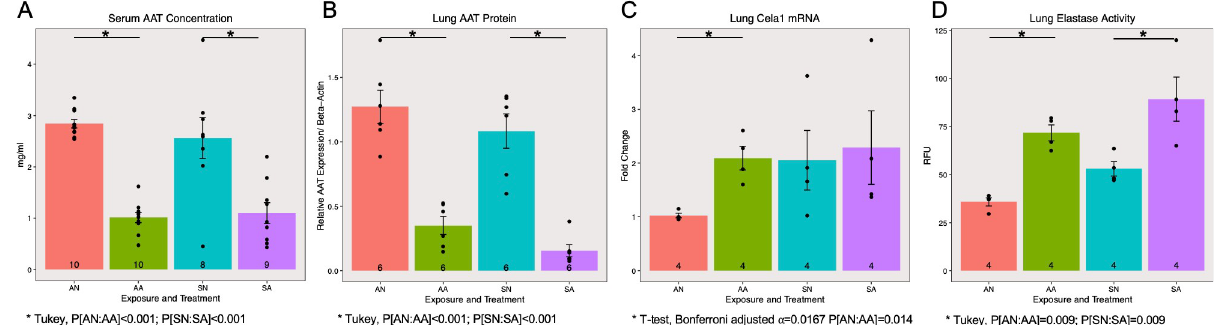
Fig 2. AAT ASO knocks down AAT in smoke-induced COPD model. Alpha-1 antitrypsin (AAT) expression was significantly decreased by the antisense oligonucleotide treatment in both serum (A, P[treatment] < 0.001) and lung (B, P[treatment] < 0.001) samples. The mRNA level of chymotrypsin-like elastase 1 ( Cela1 ) was significantly increased by AAT antisense from baseline controls (C, P[ANvsAA] = 0.014) and elastase activity in the lung was significantly increased by both smoke exposure (D, P[exposure] = 0.020) and antisense treatment (D, P[treatment] < 0.001).